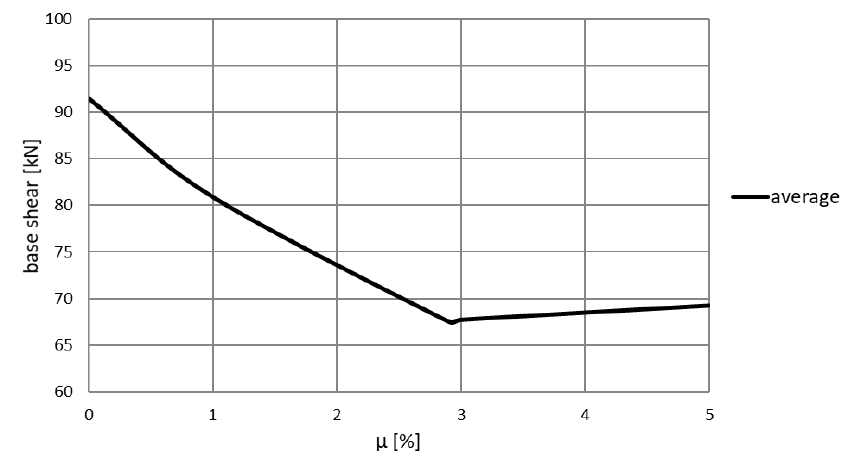
Figure 8. Base shear against the mass ratio, μ considering the TMD positioned at 26.50 m.